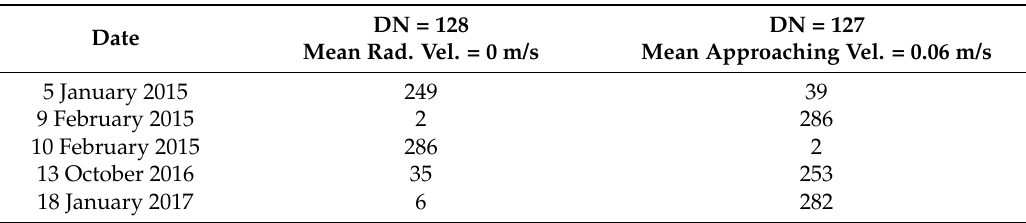
Table 1. Daily number of occurrences (temporal resolution is 5 min) of the mean radial velocity values for the high resolution Monte Lema radar cell on Cimetta that hosts the tall tower. DN = 128 DN = 127 Date Mean Rad. Vel. = 0 m/s Mean Approaching Vel. = 0.06